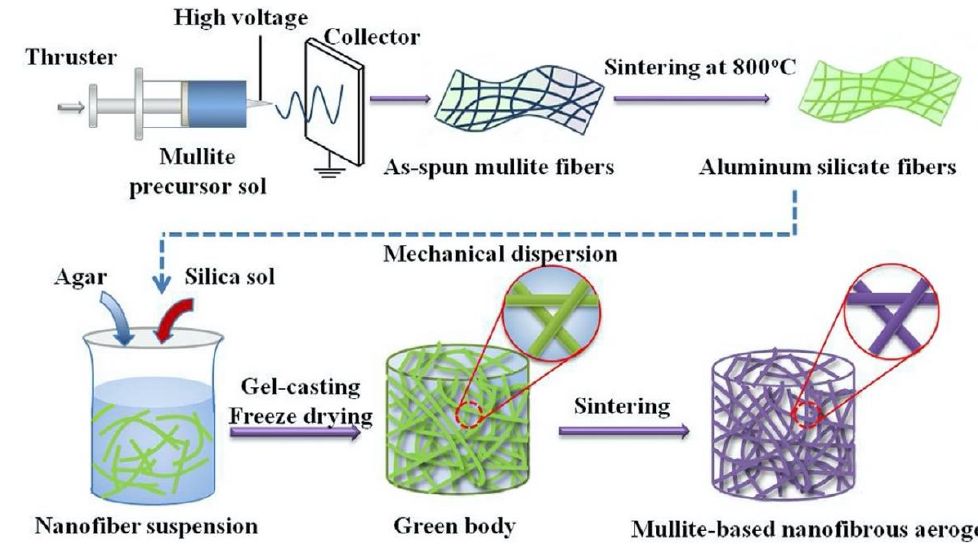
Figure 8. The fabrication process of the mullite-based nanofibrous aerogel (Reprinted with permission from Ref. [44]. 2018 Elsevier).